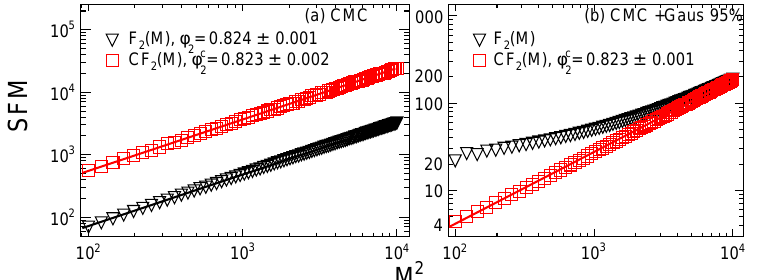
( M ) and CF ( M ) as a function of M 2 in pure CMC events. (b) The Figure 2: (a) F 2 2 result in CMC events contaminated with Gaussian background